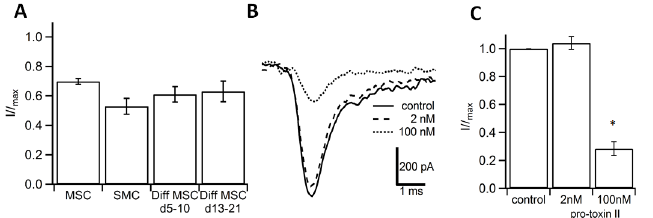
Fig 7. Blockage of voltage-gated Na + channel subtypes. (A) Application of 100nM ranolazine reduced the peak amplitude of voltage-activated Na + channels [( n = 3 for undifferentiated MSCs (cultured in GMP expansion medium), n = 4 for SMCs, n = 5 for MSCs that were differentiated for 5 – 10 days and n = 7 for MSCs differentiated for 13 – 21 days (Diff MSC)] compared to the respective control (= 1.0, not shown). (B) Application of pro-toxin II inhibited voltage-gated Na + channels in SMCs. Superposition of single current traces obtained in control (bold), at 2nM (dashed) and 100nM (dotted) from one donor, respectively. (C) Summary plot of current inhibition by pro-toxin II. Data obtained from n = 4 experiments. * p < 0.05. Error bars indicate